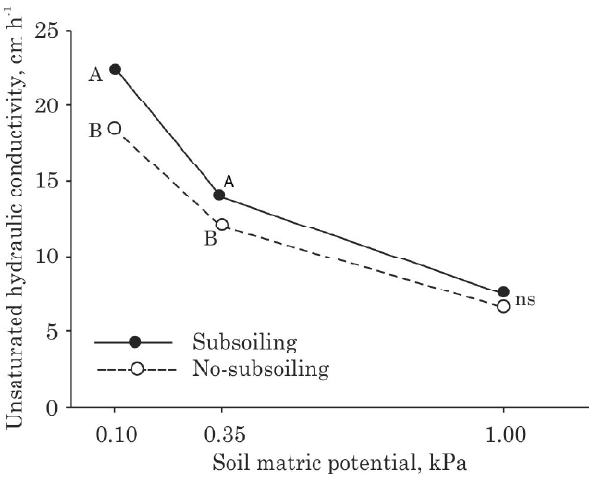
Figure 4. Unsaturated hydraulic conductivity measured in the soil surface layer, in the soil no- subsoiling and subsoiling treatments in a citrus No-subsoiling: without tilling the soil; subsoiling on both sides orchard. Where are these different letters of the plant lines; TP: soil total porosity; q : field capacity; WA: FC indicate significant differences between water availability to the plants. ns: not significant. Different subsoiling and no-subsoiling, and ns indicates no letters in each soil layer indicate differences between significance, based on the Tukey test (p< treatments by the Tukey test (p<0.05).